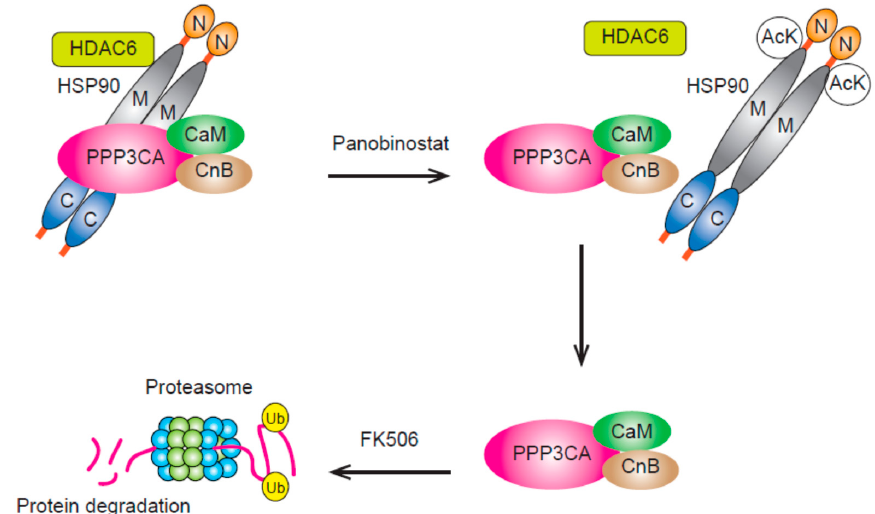
Figure 2. PPP3CA is a client protein of HSP90 and is protected from proteasomal degradation